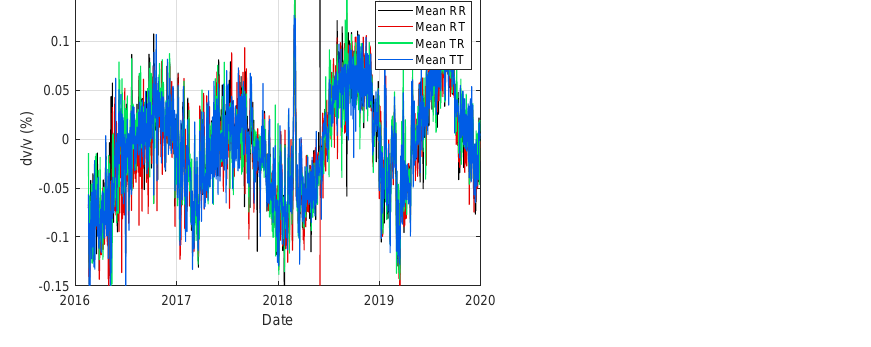
Figure 11. Time–lapse seismic velocity change retrieved from seismic ambient noise within frequency bandwidth [1.0 1.2] Hz, using the coda of the cross-coherence of individual horizontal component configurations, averaged over 78 receiver combinations.